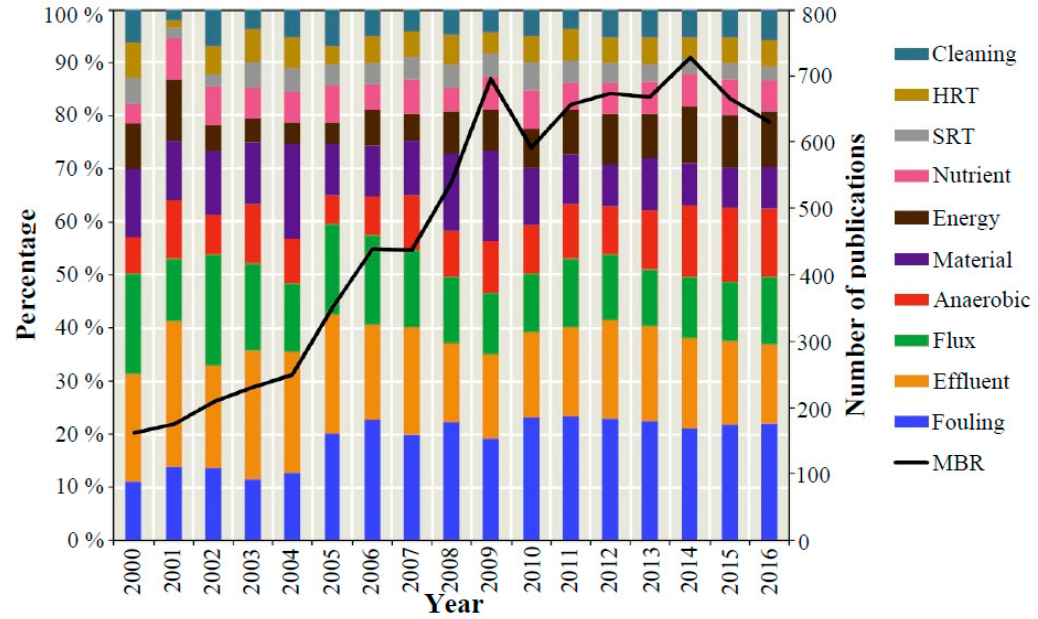
Figure 1. Research trends in MBRs based on the publication numbers in each key subject area in the Scopus (abstract and citation database of peer reviewed literature) [2].